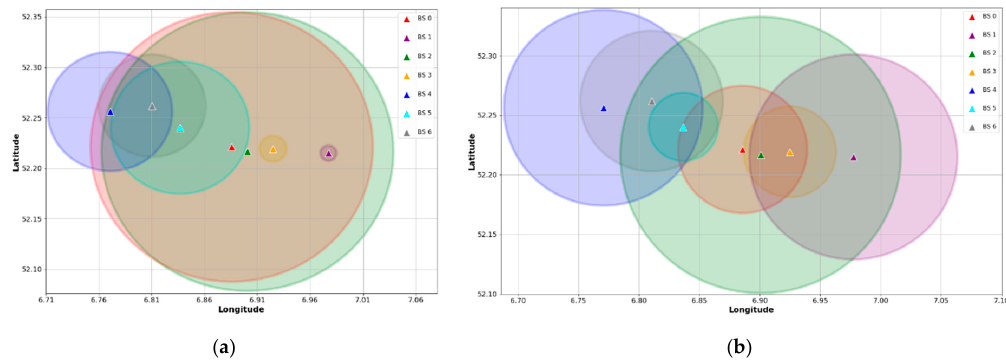
Figure 7. Device-BS association comparison: ( a ) estimated coverage based on RSSI; ( b ) CRE based on biased association.